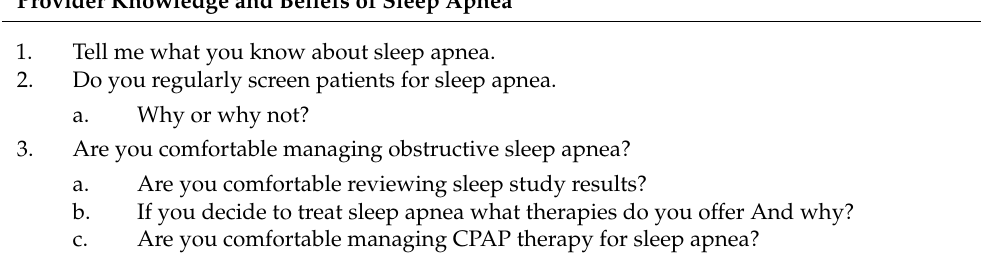
Table 1. Focus Group Guide for Rural